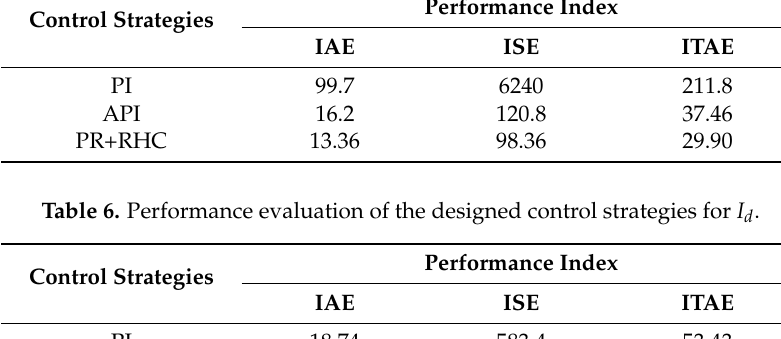
Table 5. Performance evaluation of the designed control strategies for V dc .